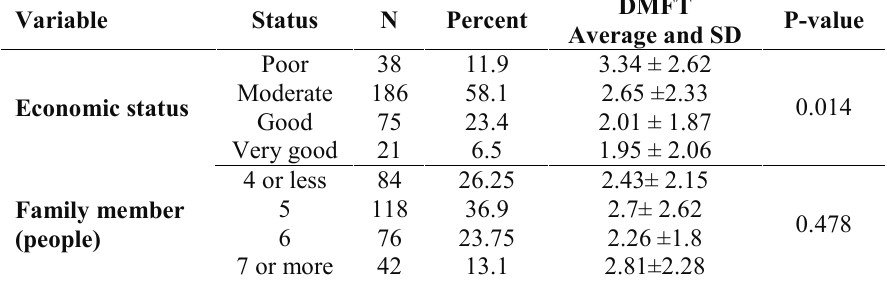
Table 5 Relationship between family size and economic situation with DMFT index.